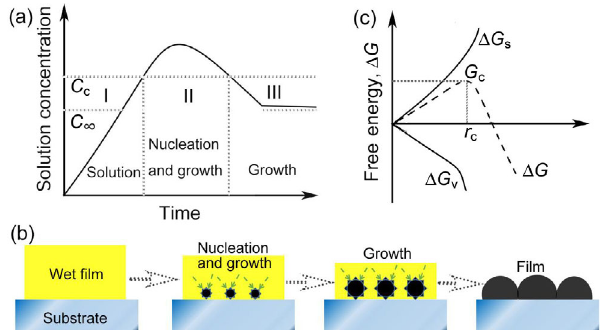
Figure 1 (a) LaMer schematic diagram for the nucleation and growth of perovskite films, where C ∞ and C c are the equilibrium concentration of solute with the bulk solid and the critical minimum concentration for nucleation, respectively. (b) Corresponding schematic illustration for nucleation and growth of perovskite films at each stage. (c) Free energy diagram for nucleation. Δ G s : surface free energy, Δ G ν : bulk free energy, Δ G : total free energy, Δ G c : critical free energy, and r c : critical radius of